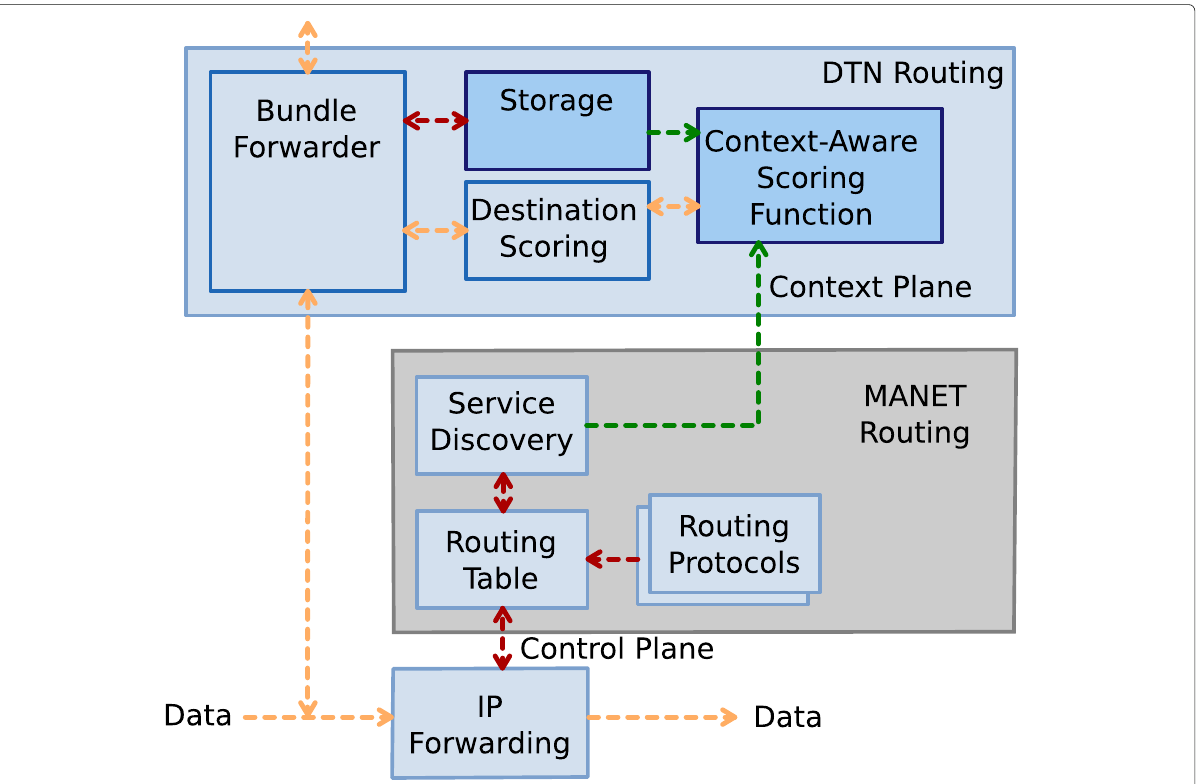
Fig. 5 Conceptual design of hybrid interaction between DTN protocols with contact-aware scoring and MANET service